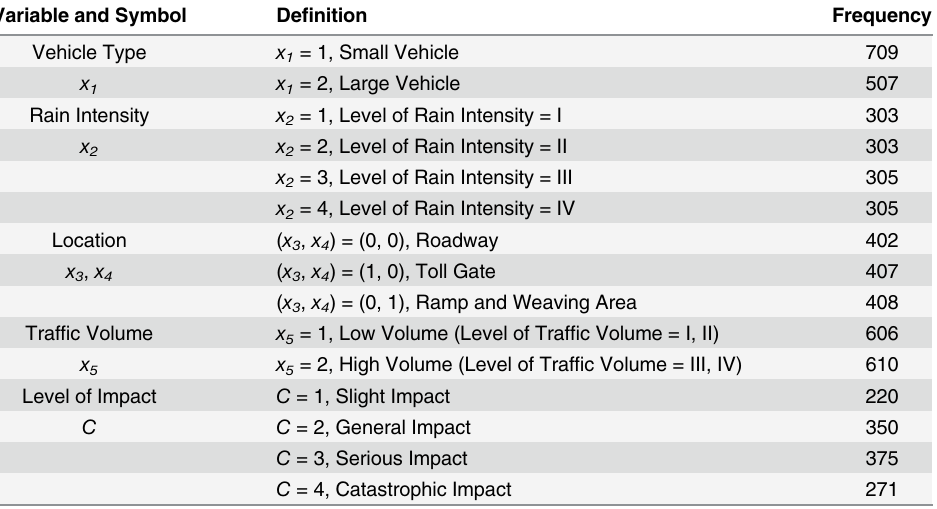
Table 3. Symbols and definitions of variables in the ordered logit